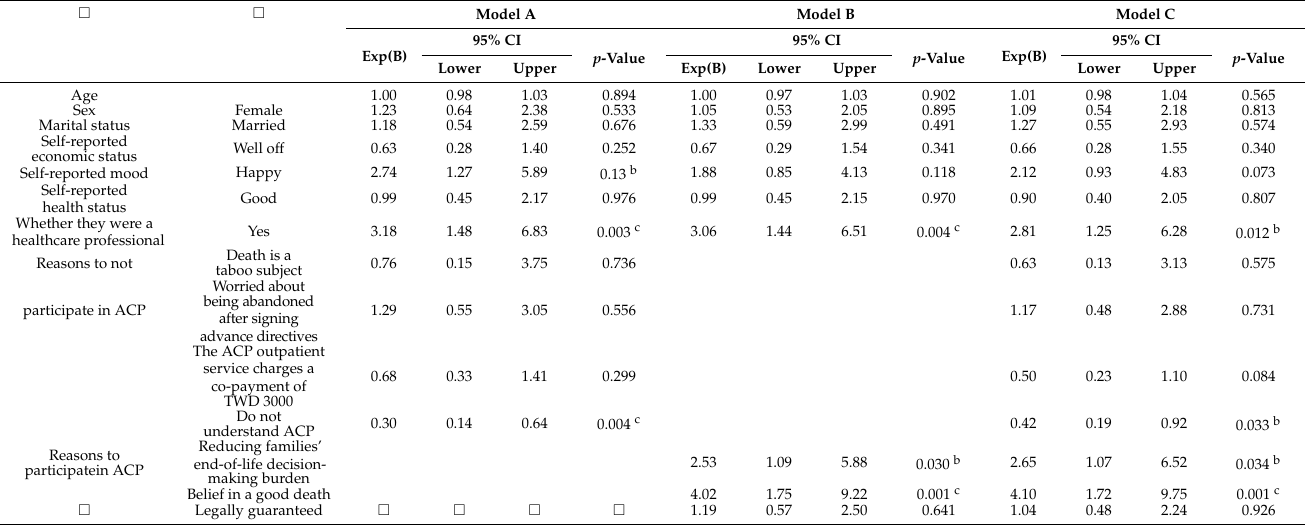
Table 3. Factors influencing the willingness to participate in ACP a .